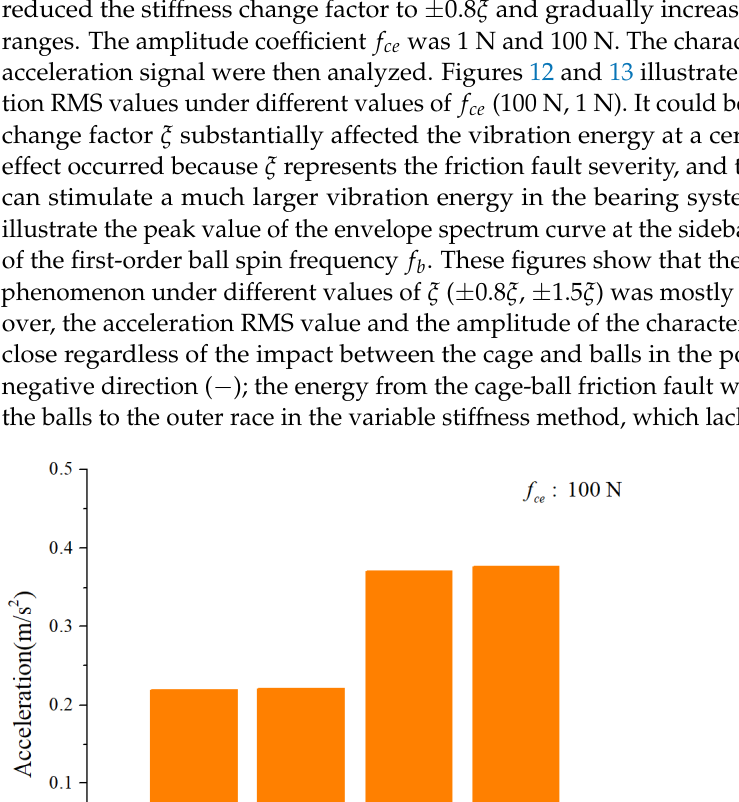
Figure 11. Acceleration envelope spectrum.